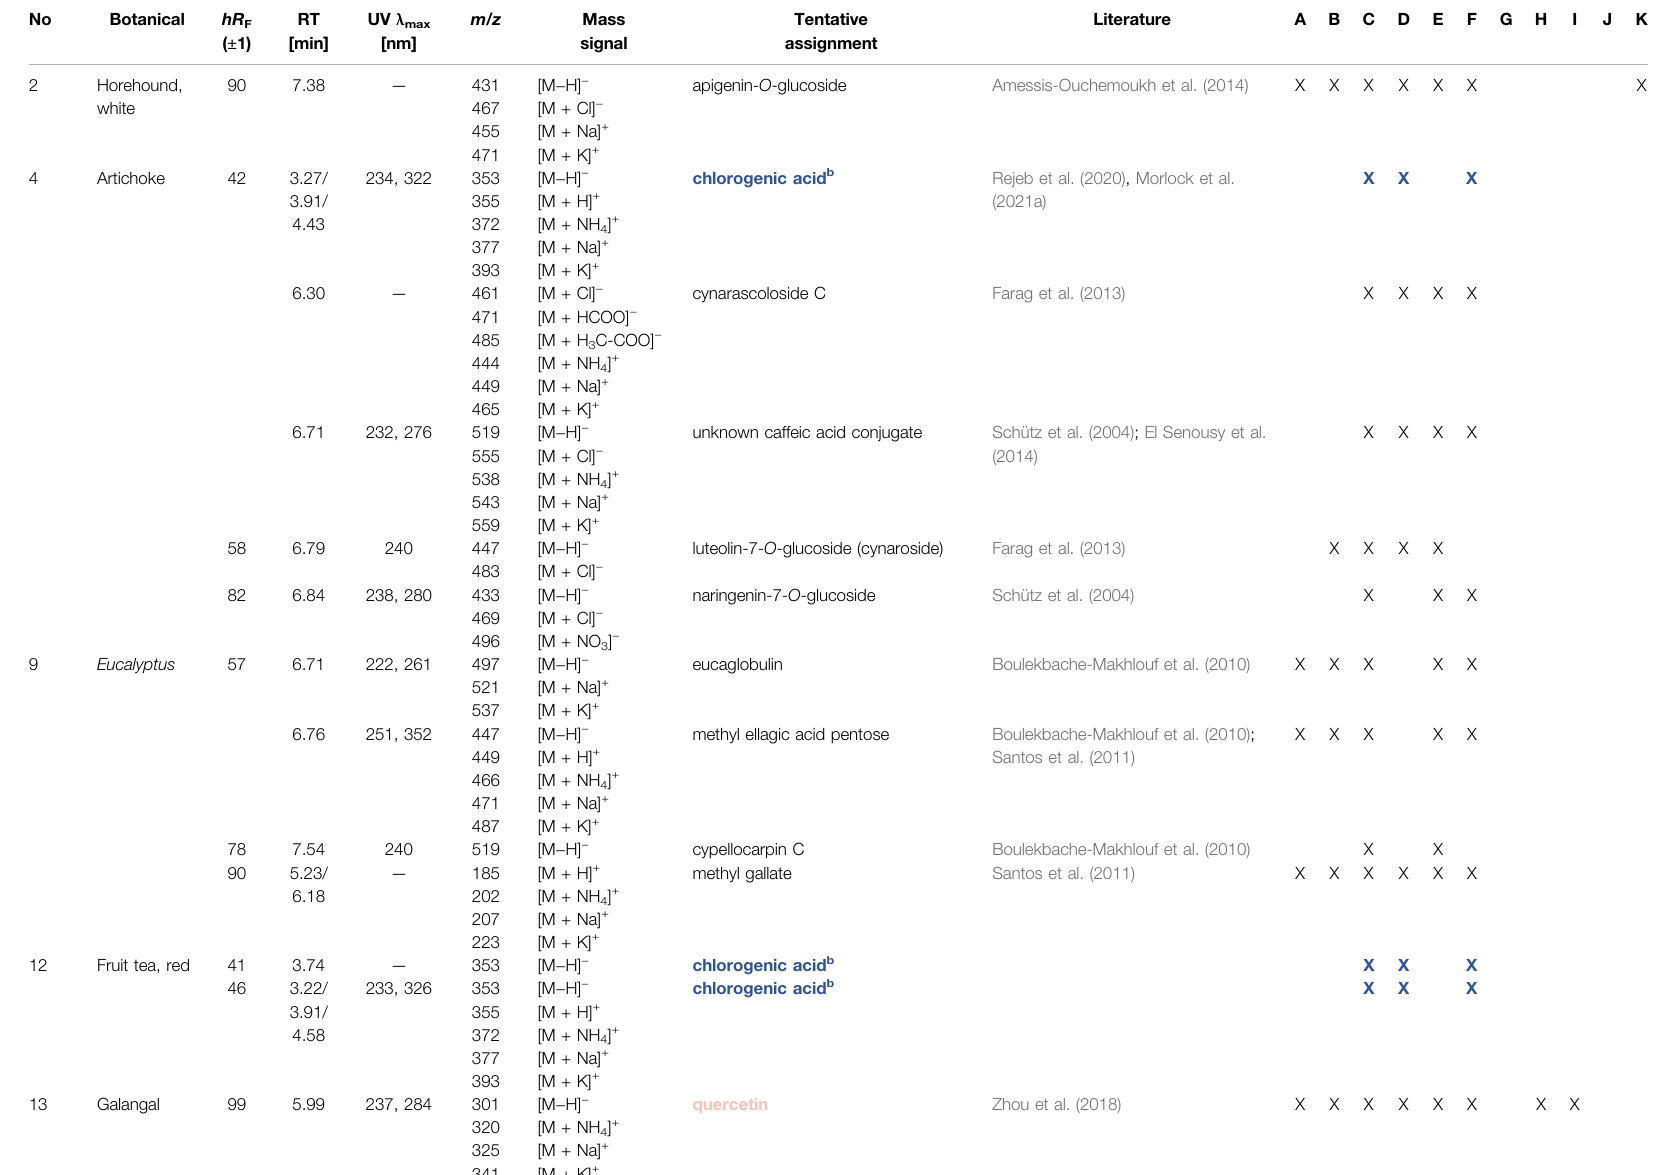
TABLE 2 | NP-HPTLC-EDA-RP-HPLC-DAD-HESI-MS signals of bioactive zones and respective activity (X) in B. subtilis (A) , A. fi scheri (B) , AChE/BChE (C) , α -/ β -glucosidase (D) , β -glucuronidase (E) , tyrosinase (F) , pYAS (G) , pYES (H) , pYAAS (I) , pYAES (J) and α -amylase (K) . In blue: analytes and respective bioactivity, which were con fi rmed by a standard; in rose: rebutted ones. No Botanical